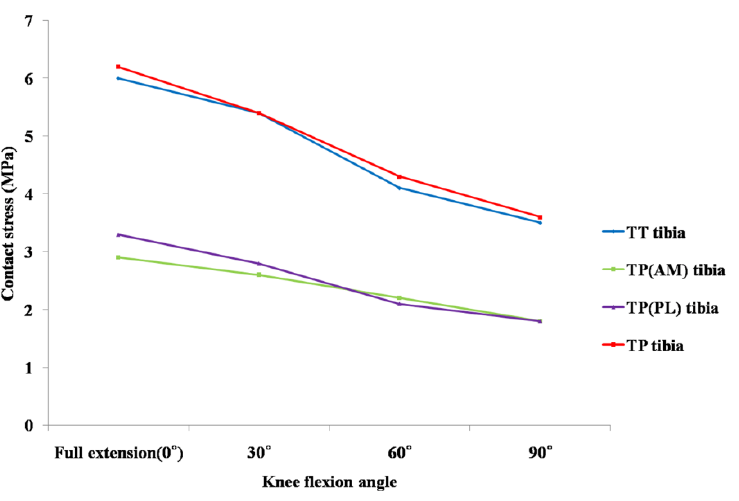
Figure 7. Comparison of contact stress at the tibial tunnel under 134 N anterior tibial load between conventional single-bundle and anatomical double-bundle anterior cruciate ligament reconstruction. Abbreviations: TT, transtibial; TP, transportal; AM, anteromedial; PL, posterolateral.